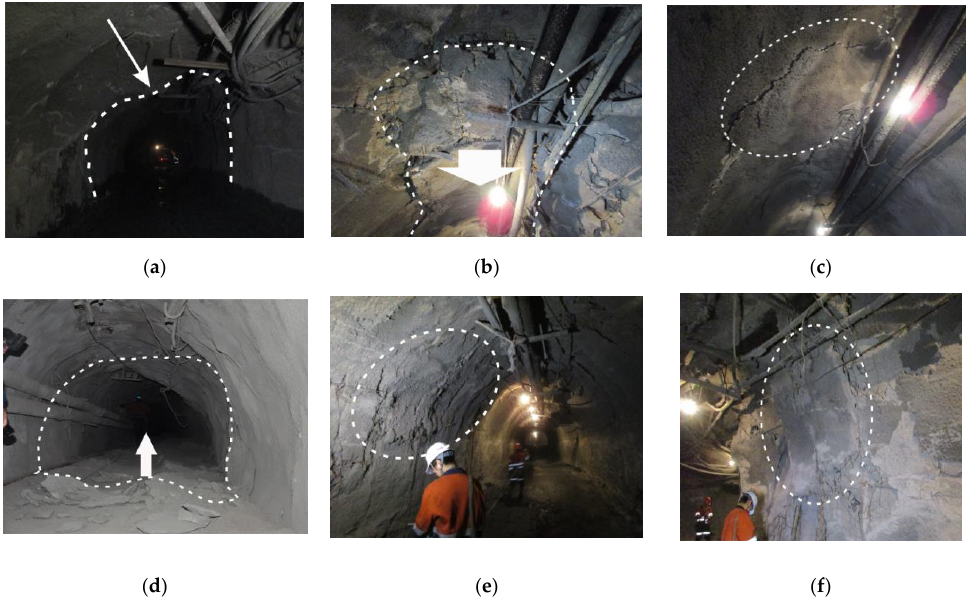
Figure 5. Deformation failure modes: ( a ) Unsymmetrical pressure, ( b ) Roof falling, ( c ) Roof cracking, ( d ) Floor heaving, ( e ) Side cracking, ( f ) Rib spalling.